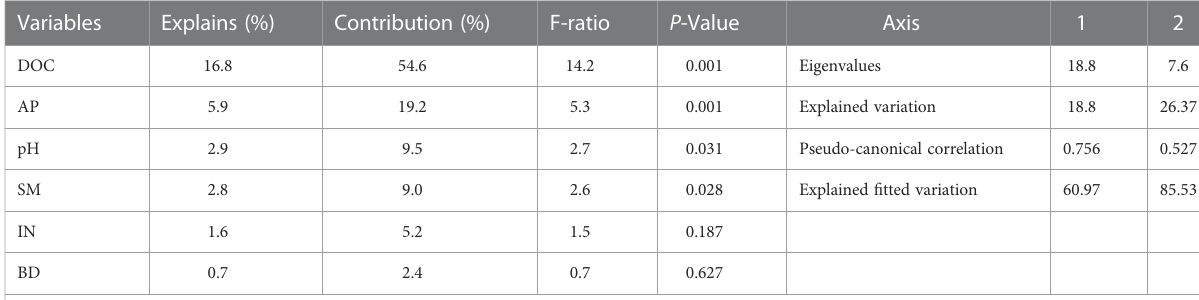
TABLE 4 Redundancy analysis (RDA) of the plant-soil-microbe ecological stoichiometry and soil physicochemical properties using forward selection with a Monte Carlo permutation test.